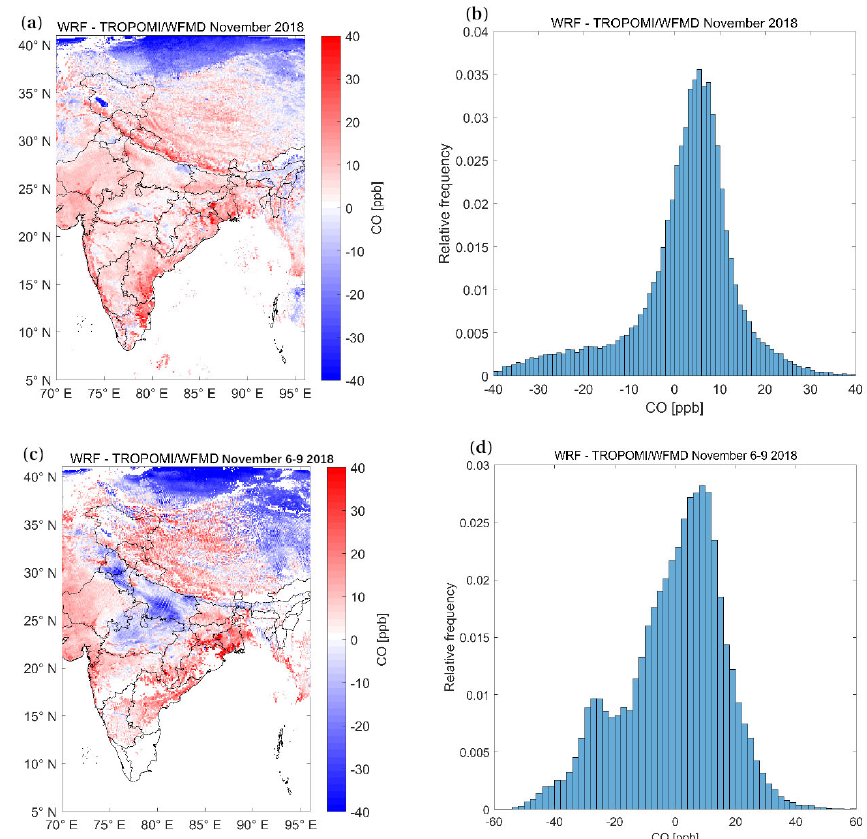
Figure 4. (a) Differences in CO total column mixing ratios (WRF – TROPOMI/WFMD) averaged over the month of November 2018. (b) Histogram of the differences. (c) Same as panel (a) but restricting the period to 6–9 November 2018. (d) Same as panel (b) but restricting the period to 6–9 November